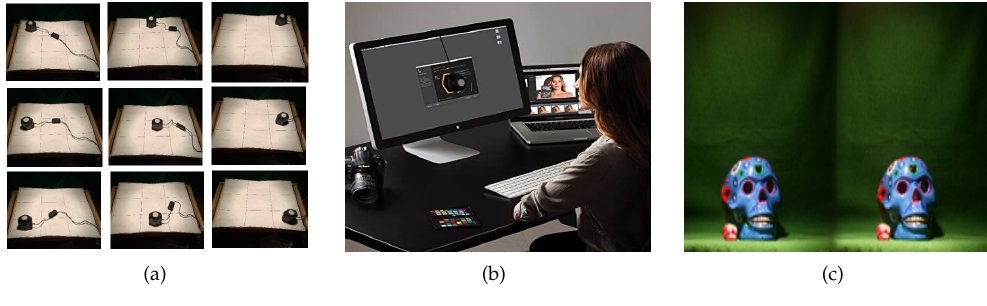
Figure 10. X-Rite Color Munki Display : ( a ) Measurement of I v inside the Dark Room, ( b ) device and ( c ) example of